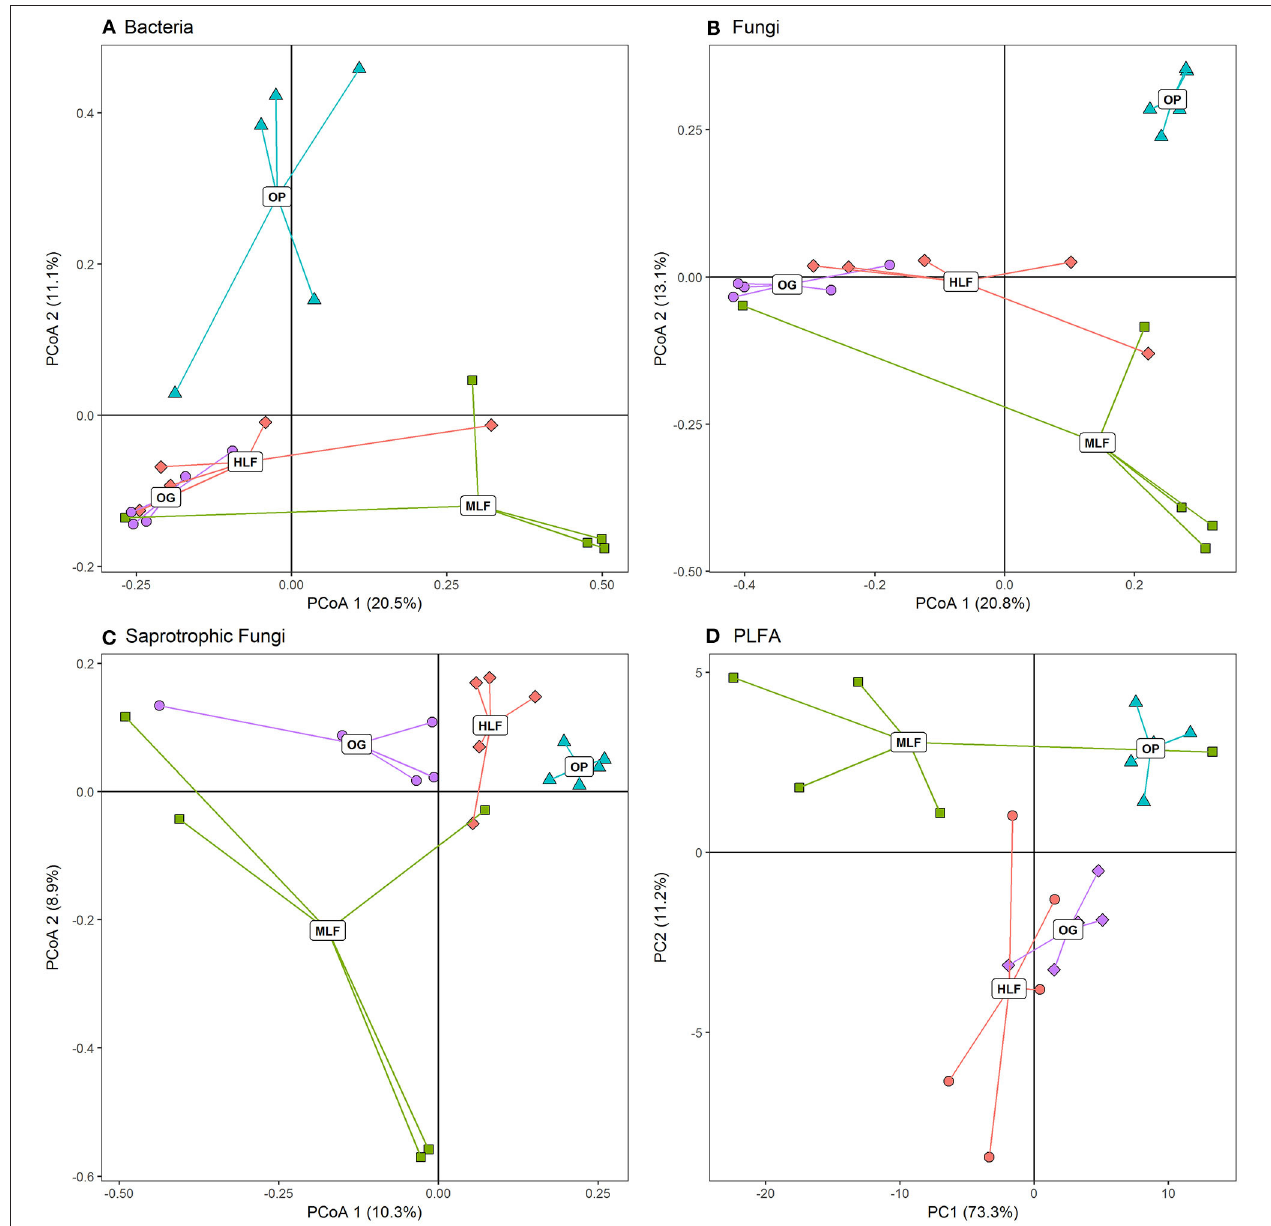
FIGURE 1 | (A–C) Principal co-ordinates analysis (PCoA) ordinations of Bray–Curtis dissimilarities of bacteria, fungal, and saprotrophic fungal microbial community composition. (D) Principal components analysis of PLFA concentrations across old–growth forest (OG), moderate logged forest (MLF), heavily logged forest (HLF), and oil palm plantation